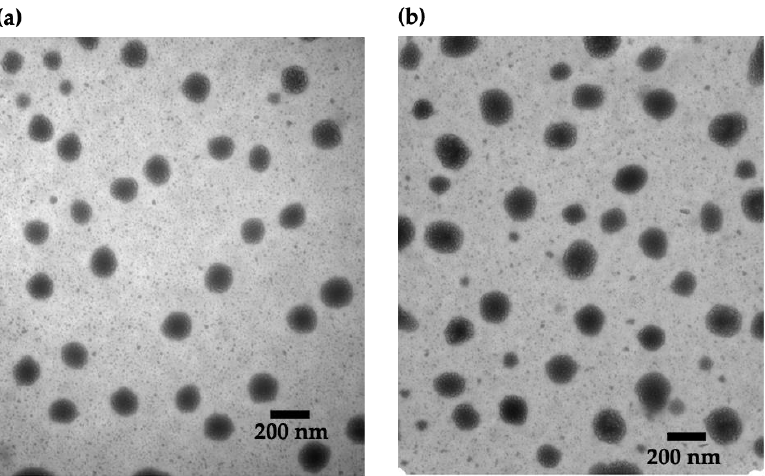
Figure 2. TEM images of CNs: ( a ) unloaded and ( b ) HTN3-loaded at a 2% w/w loading ratio. There are no obvious differences between the samples.